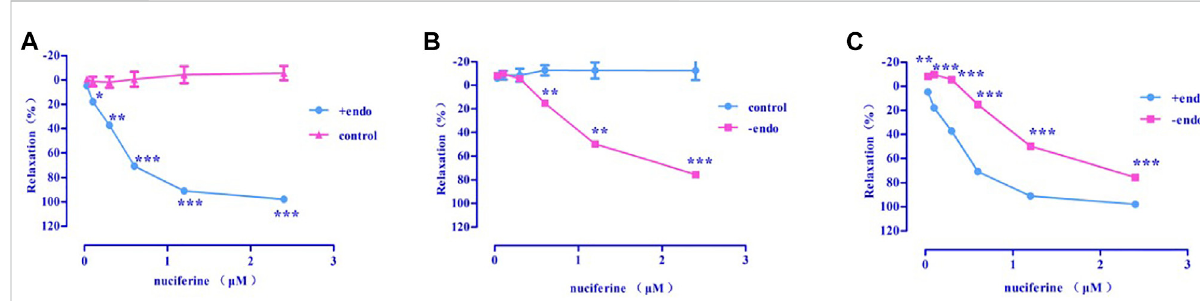
contractions by PhE or KCl, nuciferine was pre-incubated for 10 min after adding PhE or KCl. The contraction produced by highest concentration of CaCl 2 (10 mm) was taken as 100%, and